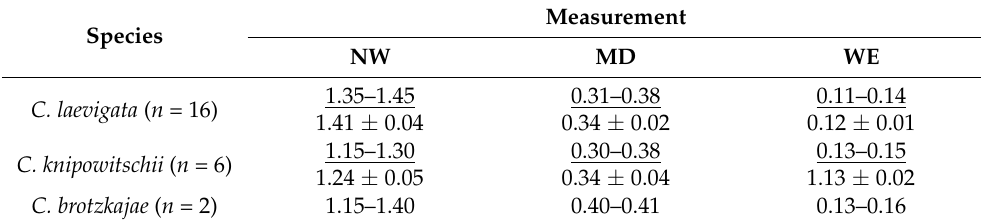
Table 3. The morphometric characteristics of the protoconchs in three Clathrocaspia species. All measurements in mm. Above lines—min–max values; below lines—mean value ± SD. Abbreviations: NW—number of whorls; MD—maximum diameter of protoconch; WE—width of initial cap-like part of embryonic